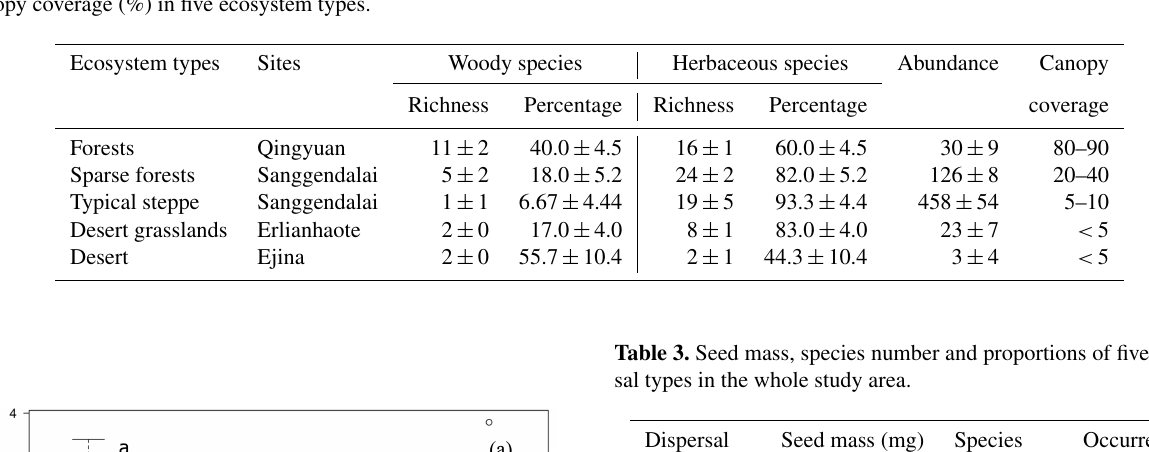
Table 2. Species richness (no. per sample area) or percentages for woody plants and herbs (%) as well as abundance (individualm − 2 ) and canopy coverage (%) in five ecosystem types.